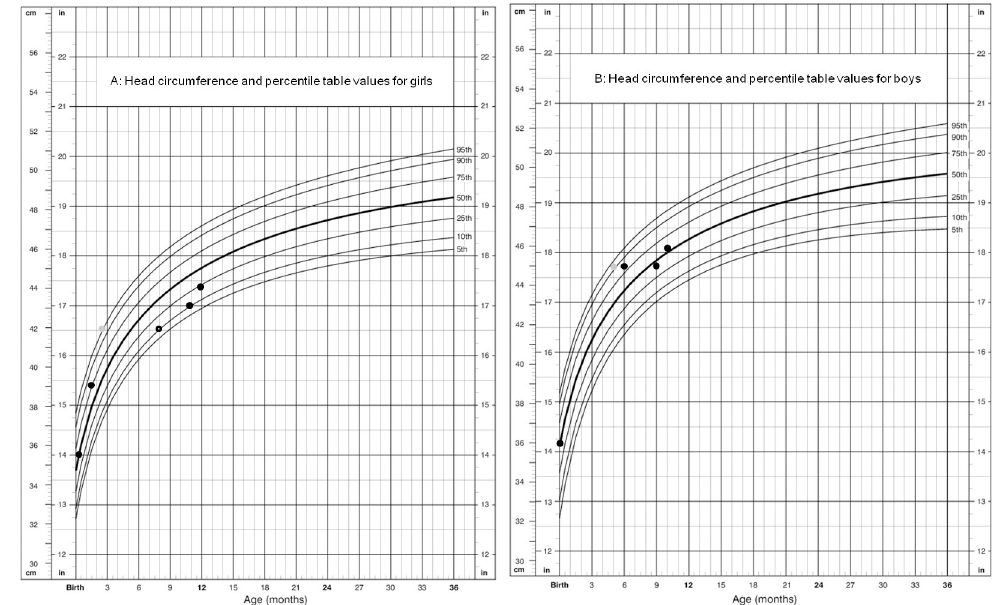
Fig 4. A. The HC stabilisation after VPS Implantation in a girl with IVH-H. At birth the child presented HC of 35.5 cm (50th Percentile; black dots). At the age of 1.5 months the HC raised to 39 cm (75th Percentile). One month later the HC increased to 42 cm showing too fast and abnormal acceleration of HC. VPS was then implanted with initial valve pressure of 5 cm H 2 O (gray dot). The HC and transfontanelle ultrasonography VS measurements were performed every 2 weeks and the HC stabilized at 42 cm during 5.5 months. Due to this small and persistent HC the valve pressure was adjusted to 7 cm H 2 O (white center black dot) and at the 11th and 12th months HC normal growth stabilization was achieved (VPS: ventriculoperitoneal shunt; HC: head circumference; VS: ventricular size). B. The HC stabilization after VPS Implantation in a boy with hydrocephalus due to aquaeductal stenosis. At birth the child presented HC of 36 cm (50th Percentile; black dots). At the age of 5 months the HC raised to 45 cm (90th Percentile) and the diagnosis was established through magnetic resonance imaging. In order to avoid a drastic macrocephaly a VPS with initial valve pressure of 5 cm H 2 O was implanted (gray dot). The HC and transfontanelle ultrasonography VS measurements were performed every 2 weeks. One month later the head stopped growing and a complete stabilization of the HC was achieved without valve adjustments between the 9th and 10th months (VPS: ventriculoperitoneal shunt; HC: head circumference; VS: ventricular size; Growth Charts adapted from Centers for Disease Control and Prevention United States; May 30,